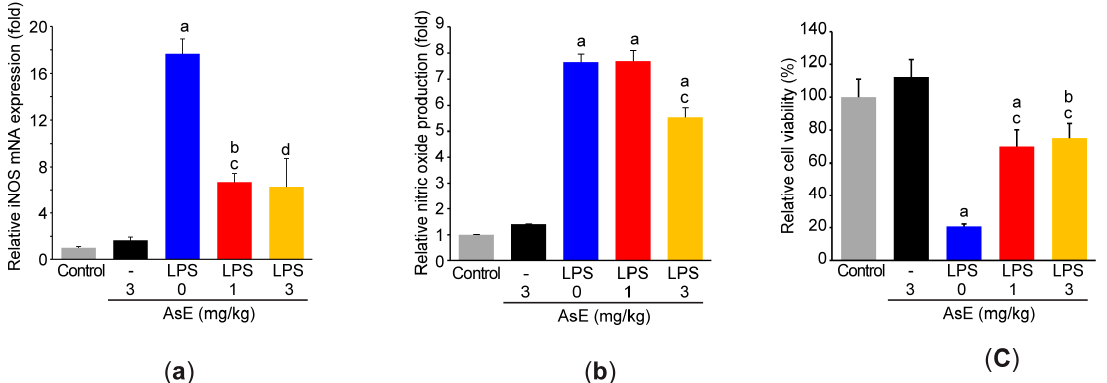
Figure 5. AsE suppresses nitric oxide production in LPS-stimulated Raw264.7 cells. ( a ) Real-time PCR. The mRNA level of iNOS was quantified after the AsE (1 or 3 mg/mL; for 1 h)-pretreated Raw264.7 cells were exposed to the LPS (1 µg/mL) for 6 h. Nitric oxide production ( b ) and cell viability ( c ) were measured after treating the cells with AsE (1 or 3 mg/mL; for 1 h) and LPS (1 µg/mL; for 18 h). a p < 0.01, b p < 0.05 versus control cells; c p < 0.01, d p < 0.01 versus LPS-treated cells; LPS, lipopolysaccharide; iNOS, inducible nitric oxide synthase.